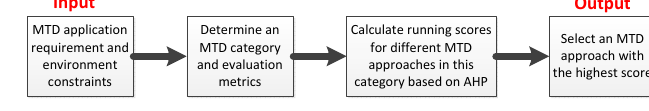
Figure 2. An overview of the generic evaluation